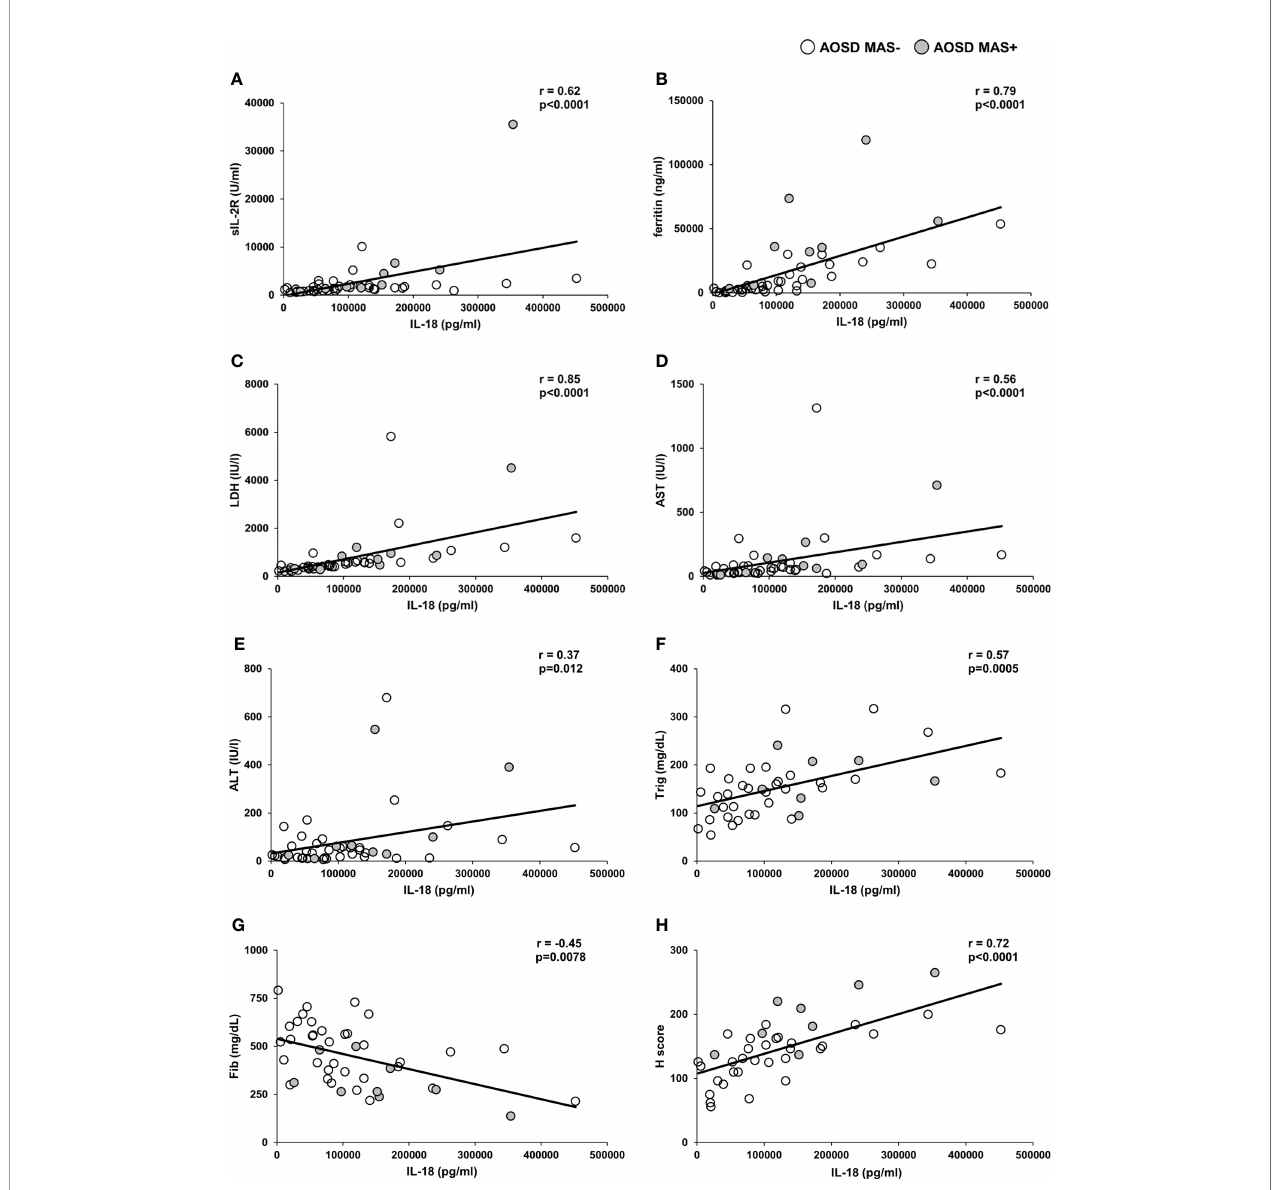
FIGURE 3 | Correlation of serum IL-18 levels and other laboratory data in the AOSD group. Serum IL-18 levels were positively correlated with sIL-2R (A) , ferritin (B) , LDH (C) , AST (D) , ALT (E) , Trig (F) and HScore (H) , and were negatively correlated with Fib (G) . The correlations were evaluated with Spearman ’ s rank correlation test. Each dot represents an individual patient; white dots indicate AOSD MAS- patients and grey dots indicate AOSD MAS+ patients. ALT, alanine transaminase; AST, aspartrate transaminase; Fib, fi brinogen; LDH, L-lactate dehydrogenase; Trig,